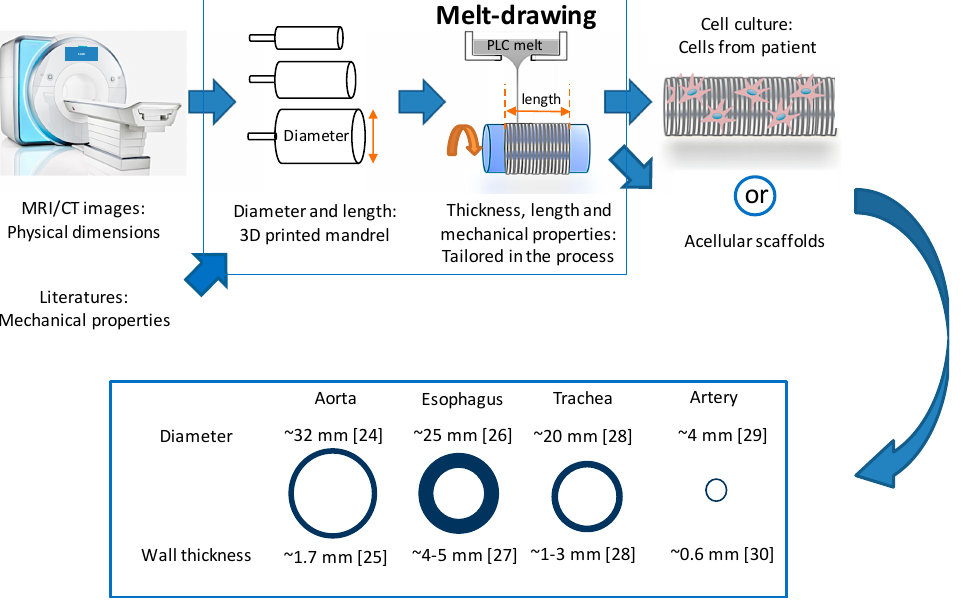
Figure 1. Schematic illustration of dimension and properties customization for scaffolds for tubular tissues [24–30] by using melt-drawing.